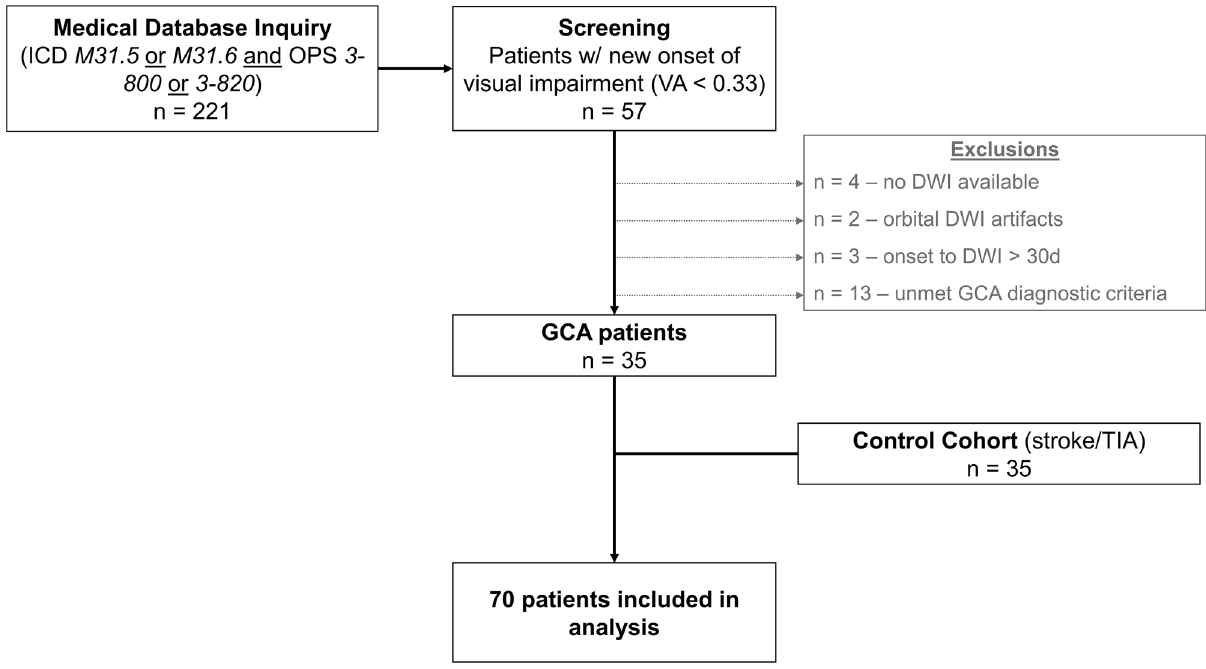
Figure 1. Flow diagram of the patient selection process. Abbreviations: DWI, diffusion-weighted imaging; GCA, giant cell arteritis; ICD, International Classification of Diseases; OPS, Operation and Procedure Classification System; TIA, transient ischemic attack; VA, visual